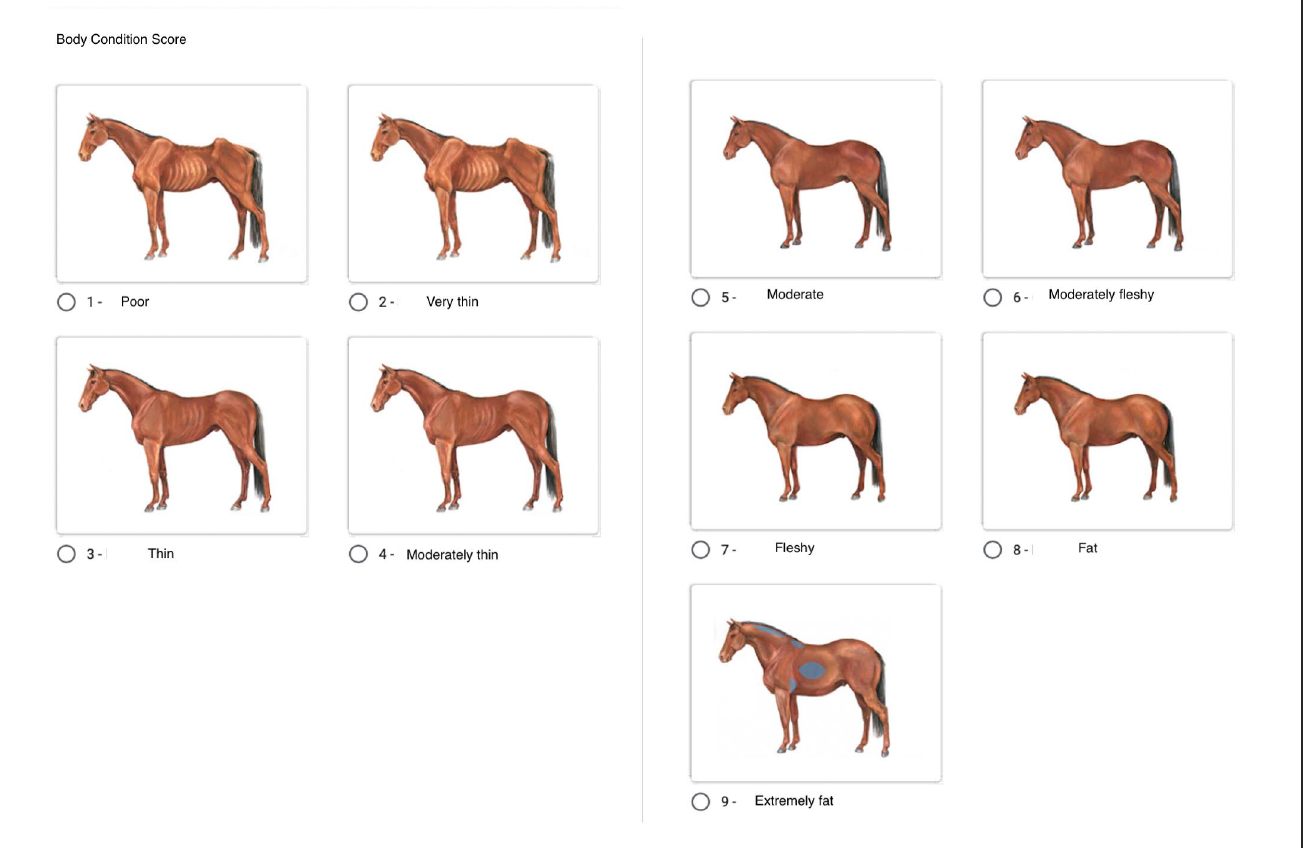
Figure 1. Illustration of the appearance of horses for each body condition score, from the Henneke scale